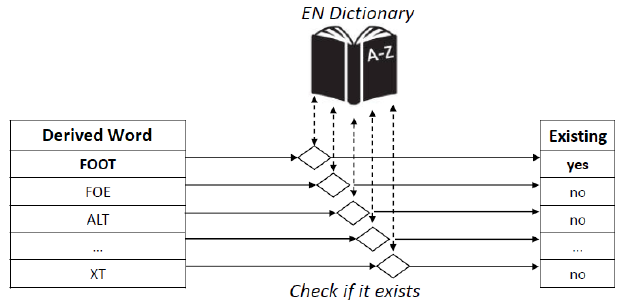
Figure 5. Selection of the derived words based on a dictionary.